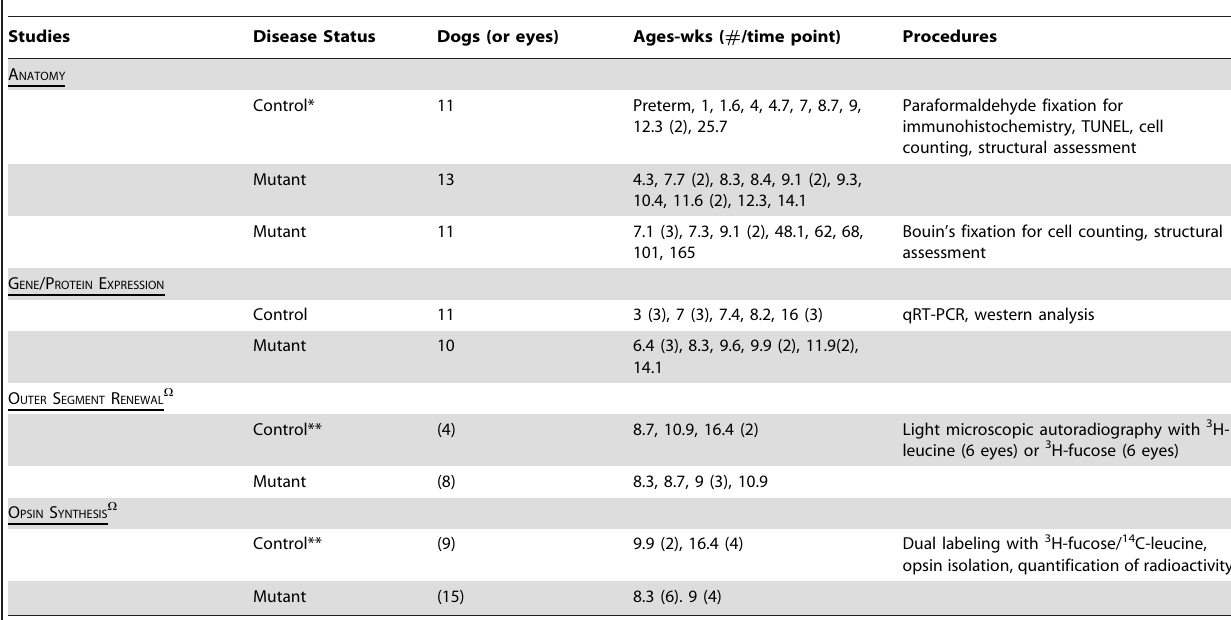
Table 1. Summary of procedures and dogs used in the studies.